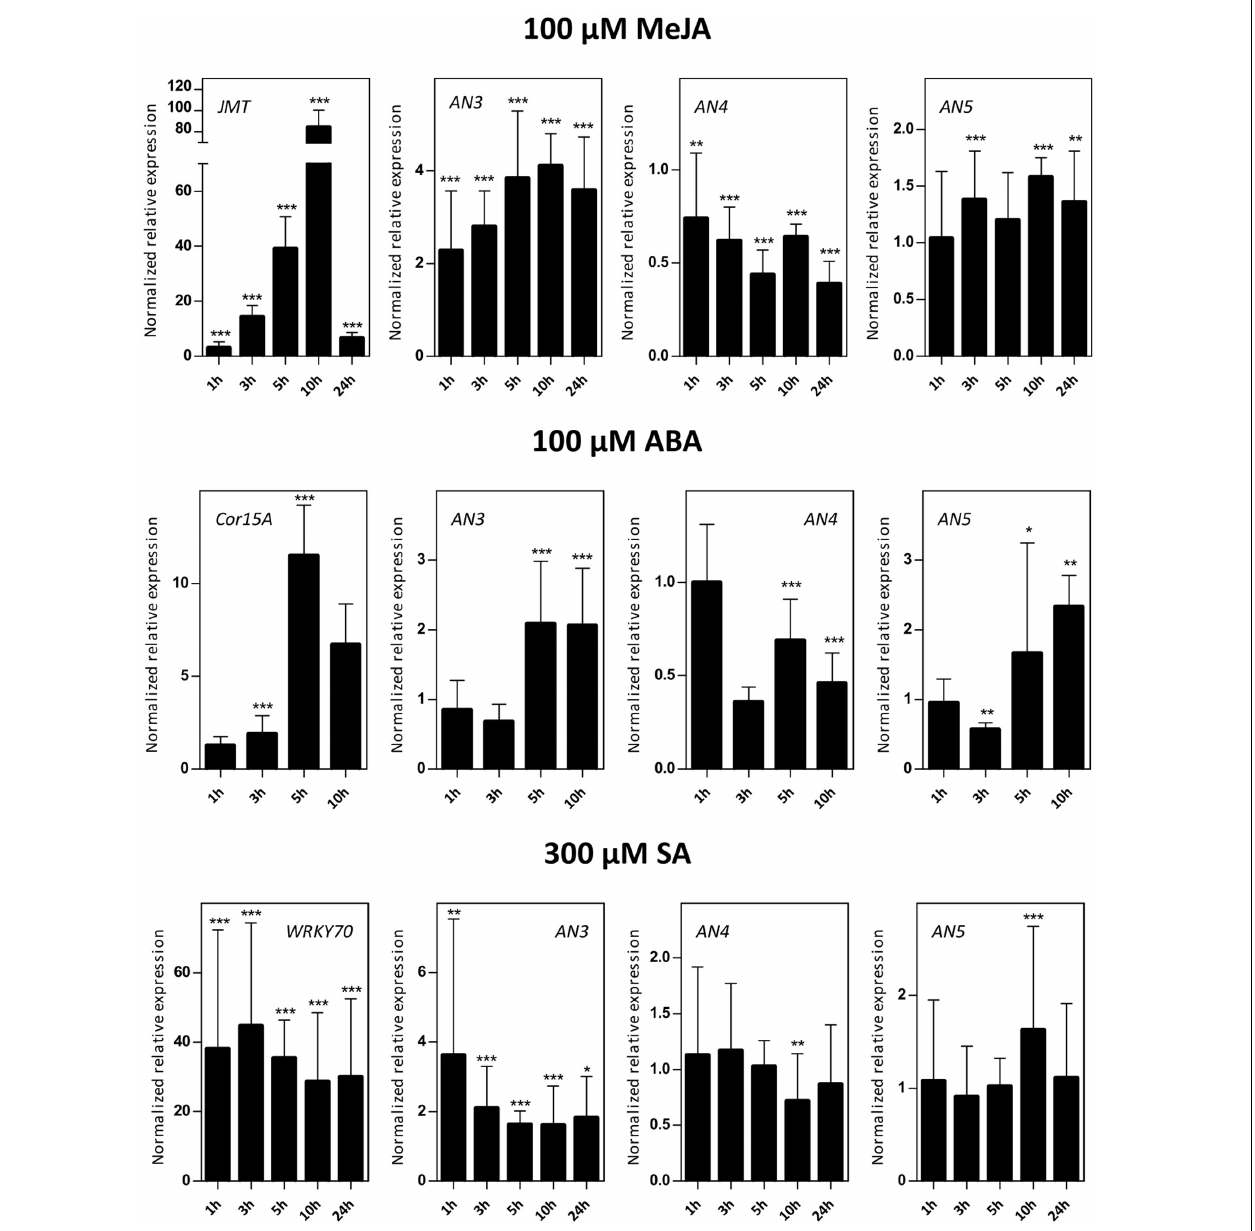
FIGURE 4 | Normalized relative expression of ArathNictaba genes after MeJA, ABA, and SA hormone treatment. The normalized transcript levels are the result of two or four independent biological replicates ( N = 2 for ABA, N = 4 for MeJA and SA). They are presented relatively to the ArathNictaba expression level determined in the mock treated plantlets. Bars represent the mean ± SE normalized relative expression and asterisks indicate statistically significant differences to the expression level of ArathNictaba in mock treated plantlets ( ∗ p ≤ 0.05, ∗∗ p ≤ 0.01, ∗∗∗ p ≤ 0.001; REST analysis). The normalized relative expression levels for the control genes for each stress are presented in the left